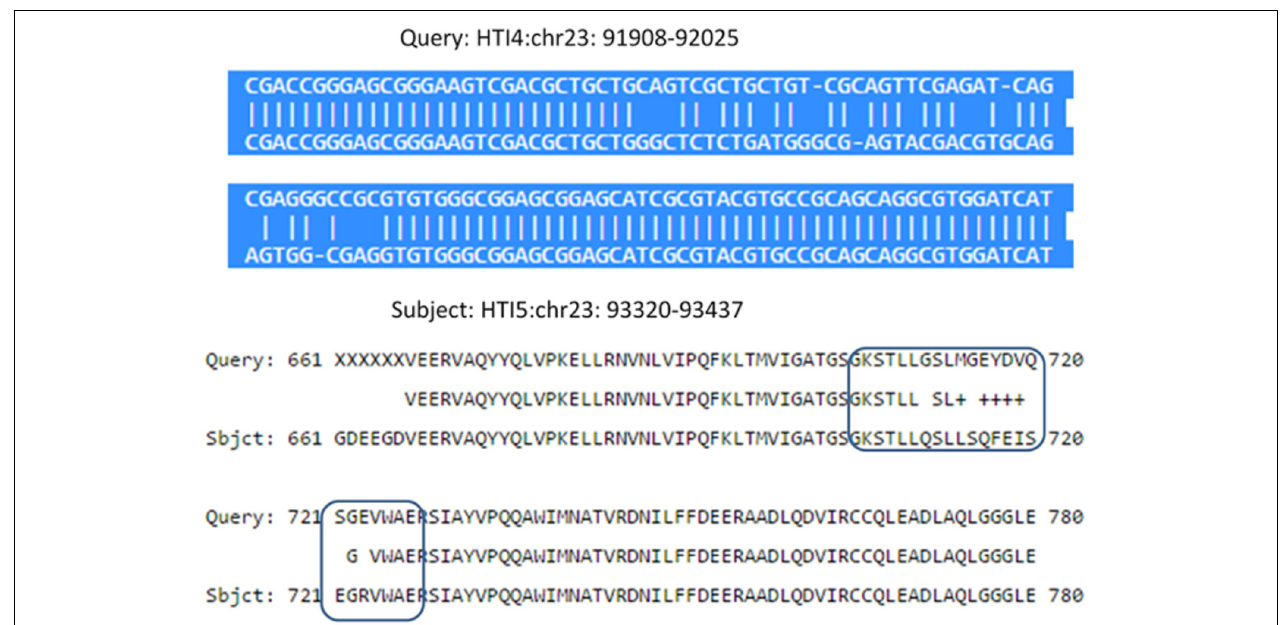
FIGURE 4 | Nucleotide and protein sequence comparison in L. donovani ABC transporter gene in Chr 23 of early and late passages. (Upper) Shows multiple nucleotide polymorphisms in HTI4 and HTI5 including indels and nucleotide substitutions. (Lower) Describes the protein sequence polymorphism as a result of sequence changes. The differences leading to functional loss are marked as boxes.